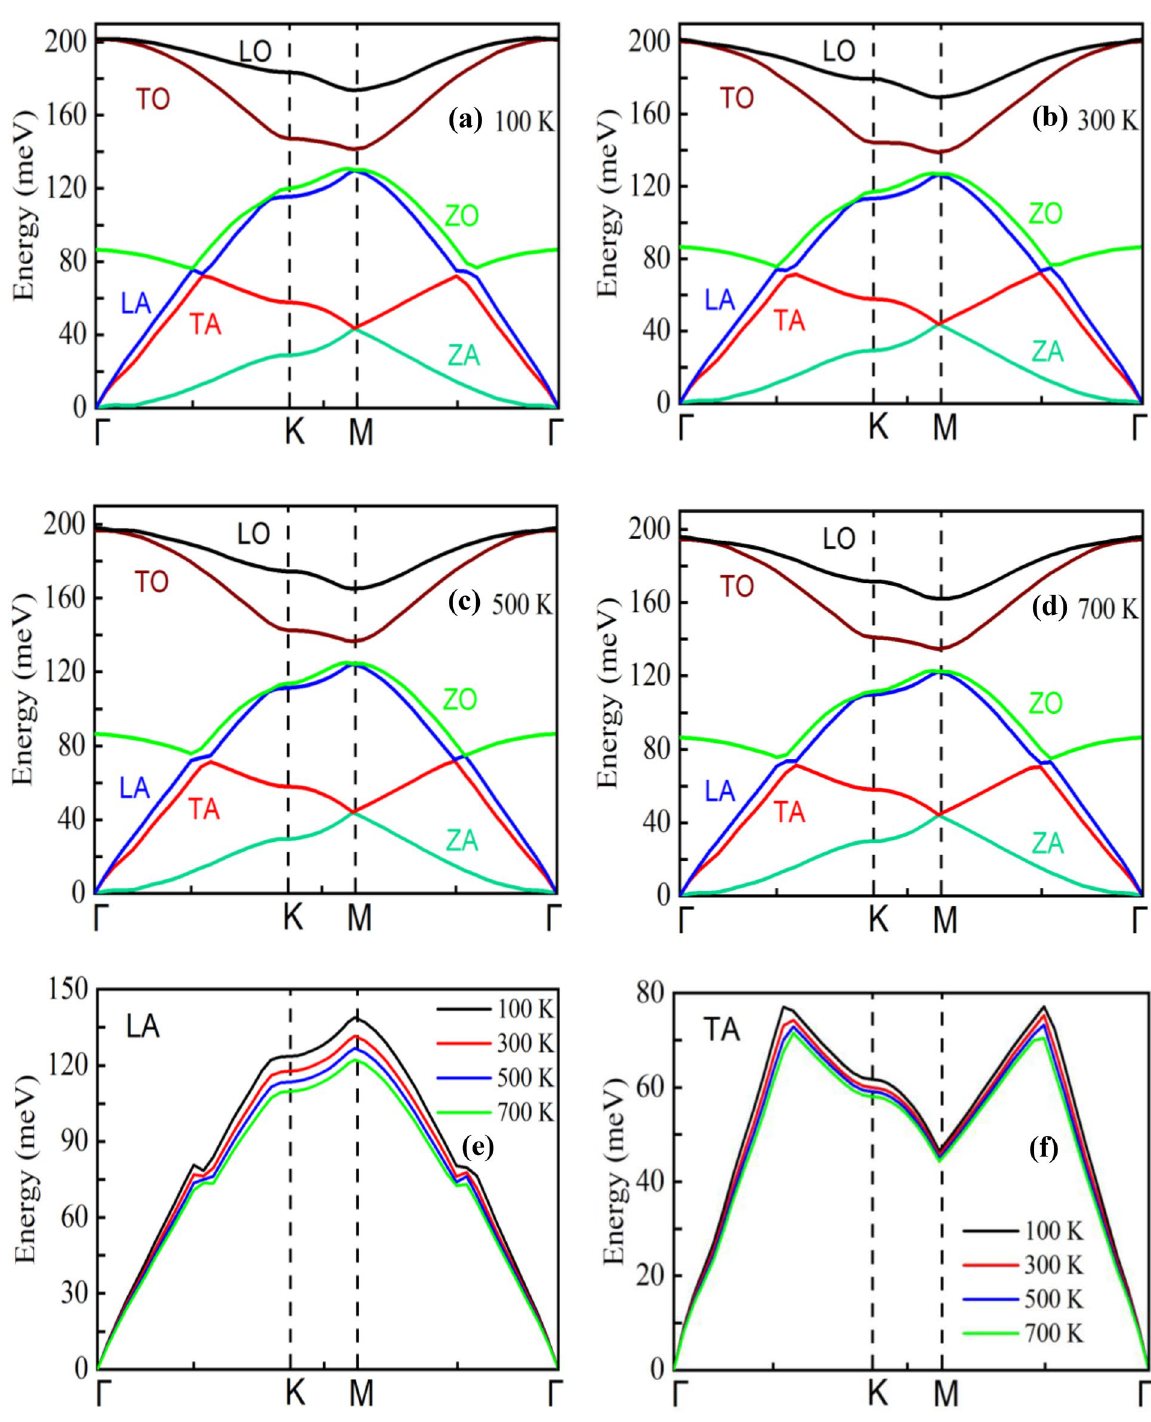
Figure 5. Phonon-dispersion relation for graphene/2D-SiC vdWH at ( a ) 100 K, ( b ) 300 K, ( c ) 500 K, and ( d ) 700 K. Temperature dependence of ( e ) LA and ( f ) TA mode